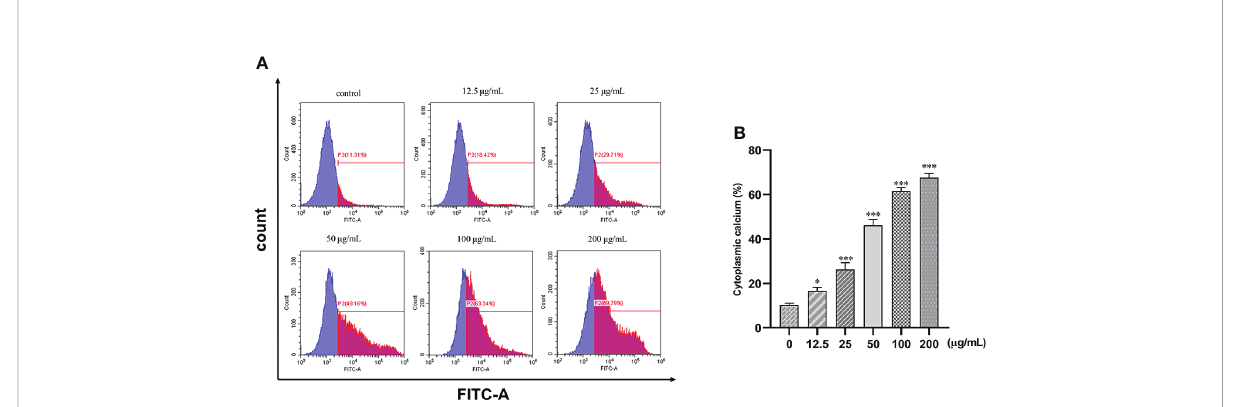
FIGURE 9 Effect of 1,2,3,4,6-pentagalloyl- b -D-glucose on intracellular Ca 2+ concentration in SGC7901 cells. SGC7901 cells were incubated with different concentrations of 1,2,3,4,6-pentagalloyl- b -D-glucose for 48 (h) Fluo-3/AM assay was performed to determine Ca 2+ concentration. (A) Intracellular Ca 2+ concentration after treatment of cells with 0, 12.5, 50, 100, and 200 m g/ml of b -PGG. (B) Average cytoplasmic calcium rate of SGC7901 cells. * p < 0.05, *** p < 0.001 vs. 0